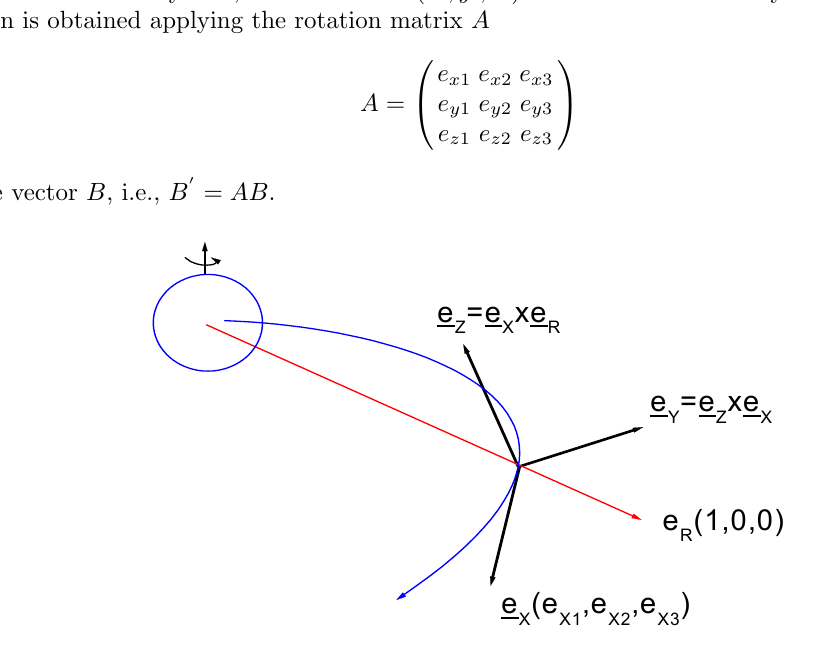
Figure 120: Mean field reference